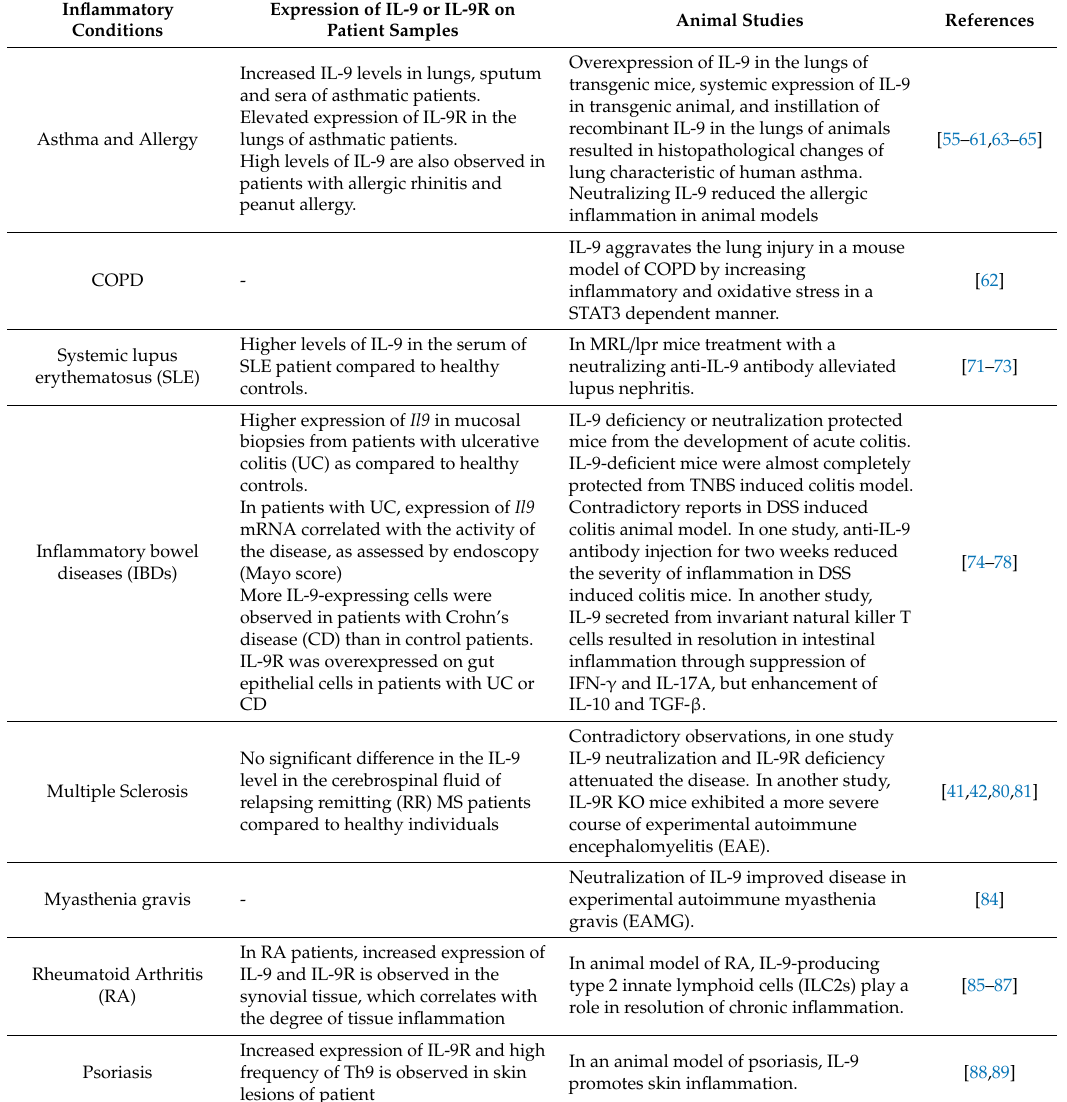
Table 1. Status of IL-9 in various inflammatory